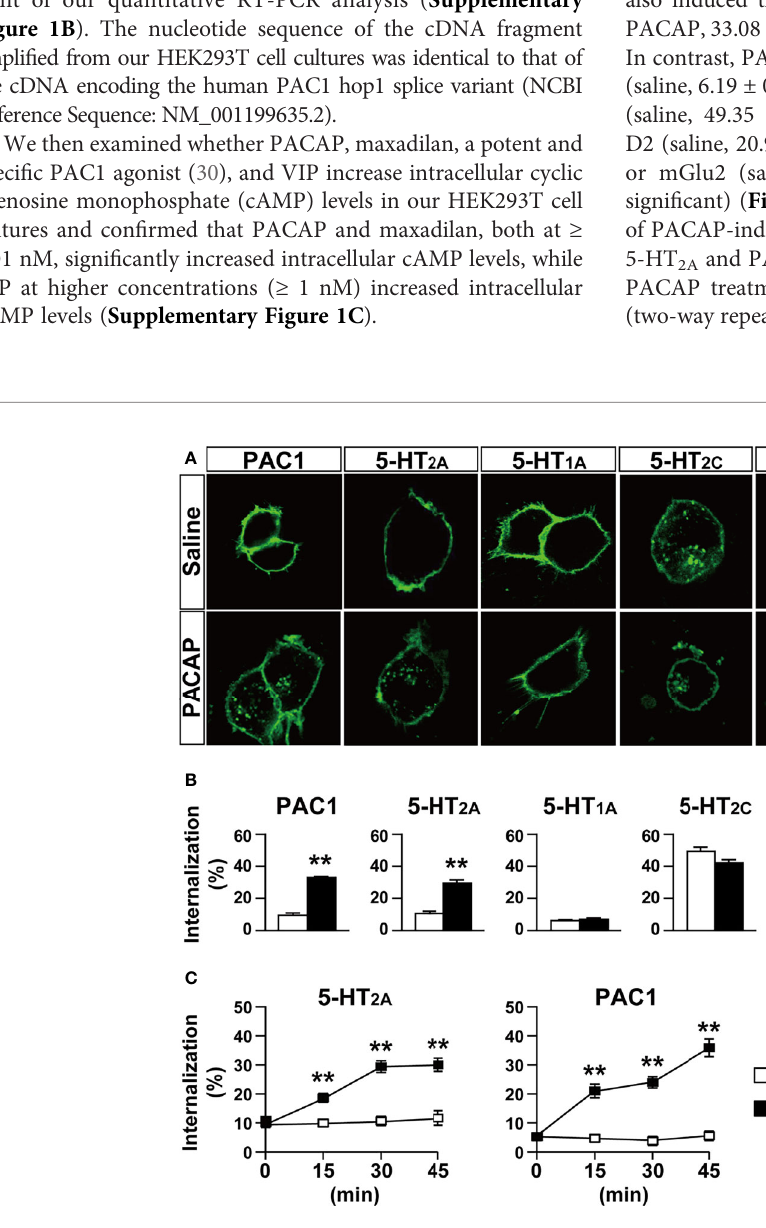
FIGURE 1 | PACAP induces internalization of 5-HT 2A in HEK293T cells. (A) Representative images of HEK293T cells transfected with the indicated HaloTag receptors. The cells were labeled with Alexa Fluor 488 HaloTag membrane impermeable ligand for 15 min and then treated with 1 m M PACAP or saline for 30 min. Scale bar, 10 m m. (B) Quanti fi cation of the indicated HaloTag receptor internalization. Values are the mean ± SEM of 40 – 64 cells obtained from three independent experiments. ** p < 0.01 vs. saline, Student ’ s t -test. (C) Time course of 5-HT 2A and PAC1 internalization for 45 min after PACAP treatment. Values are the mean ± SEM of 23 – 69 cells obtained from three independent experiments. ** p < 0.01 vs. saline, two-way repeated-measures ANOVA followed by the Tukey-Kramer